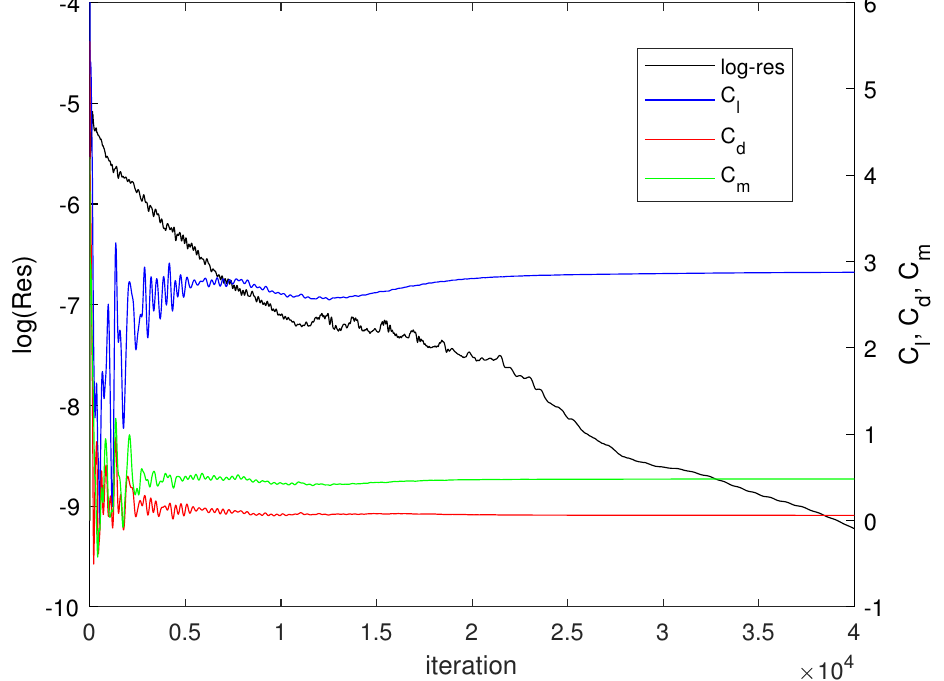
Figure 4. Residuals and aerodynamic coefficients versus iteration number of the NLR 7301 airfoil with trailing-edge flap for M ∞ = 0.185 and α = 10.1 ◦ .